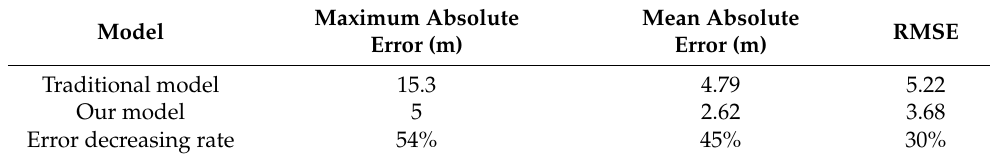
Table 7. Errors statistics using test field.